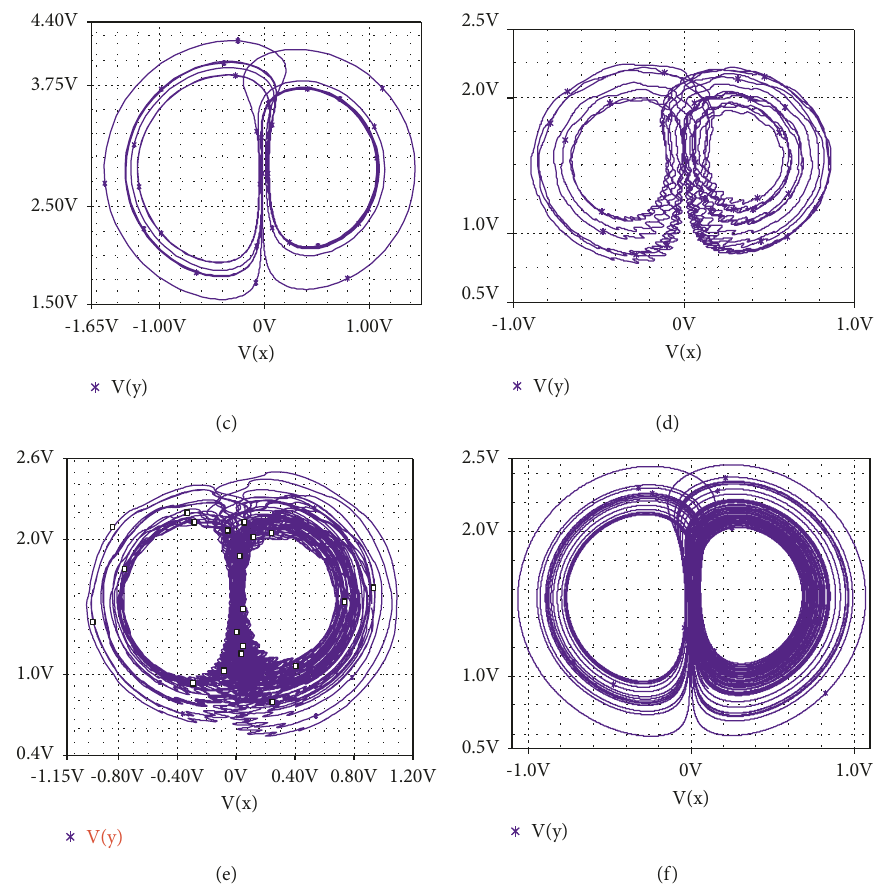
Figure 19: Behavior of the electronic circuit describing the motor driving a sinusoidal waveform. The circuit implement in OrCAD-PSpice results in the phased portraits in Figure 19 are captured. We obtained all these forms with the following value of parameters: (a) R 40 � 8000k Ω , (b) R 40 � 15M Ω , (c) R 40 � 12000k Ω , (d) R 40 � 800k Ω , (e) R 40 � 350k Ω , and (f) R 40 � 275.25k Ω and (V � 15V; F � 50Hz; R 21 � R37 � 6.4102564 k Ω ), and the rest of parameters are the same as the ones used to plot Figure 16. We can see that the analytical results are checked experimentally and a very good agreement is found between numerical and experiments